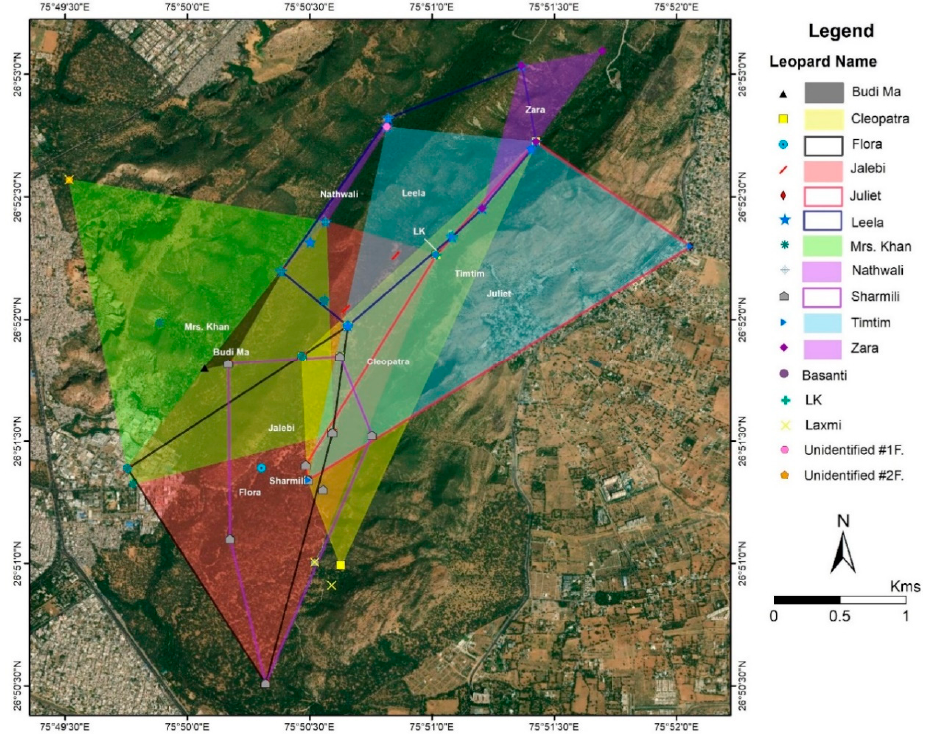
Figure 6. Home-ranges (MCPs) of female leopards of Jhalana Reserve Forest, India.